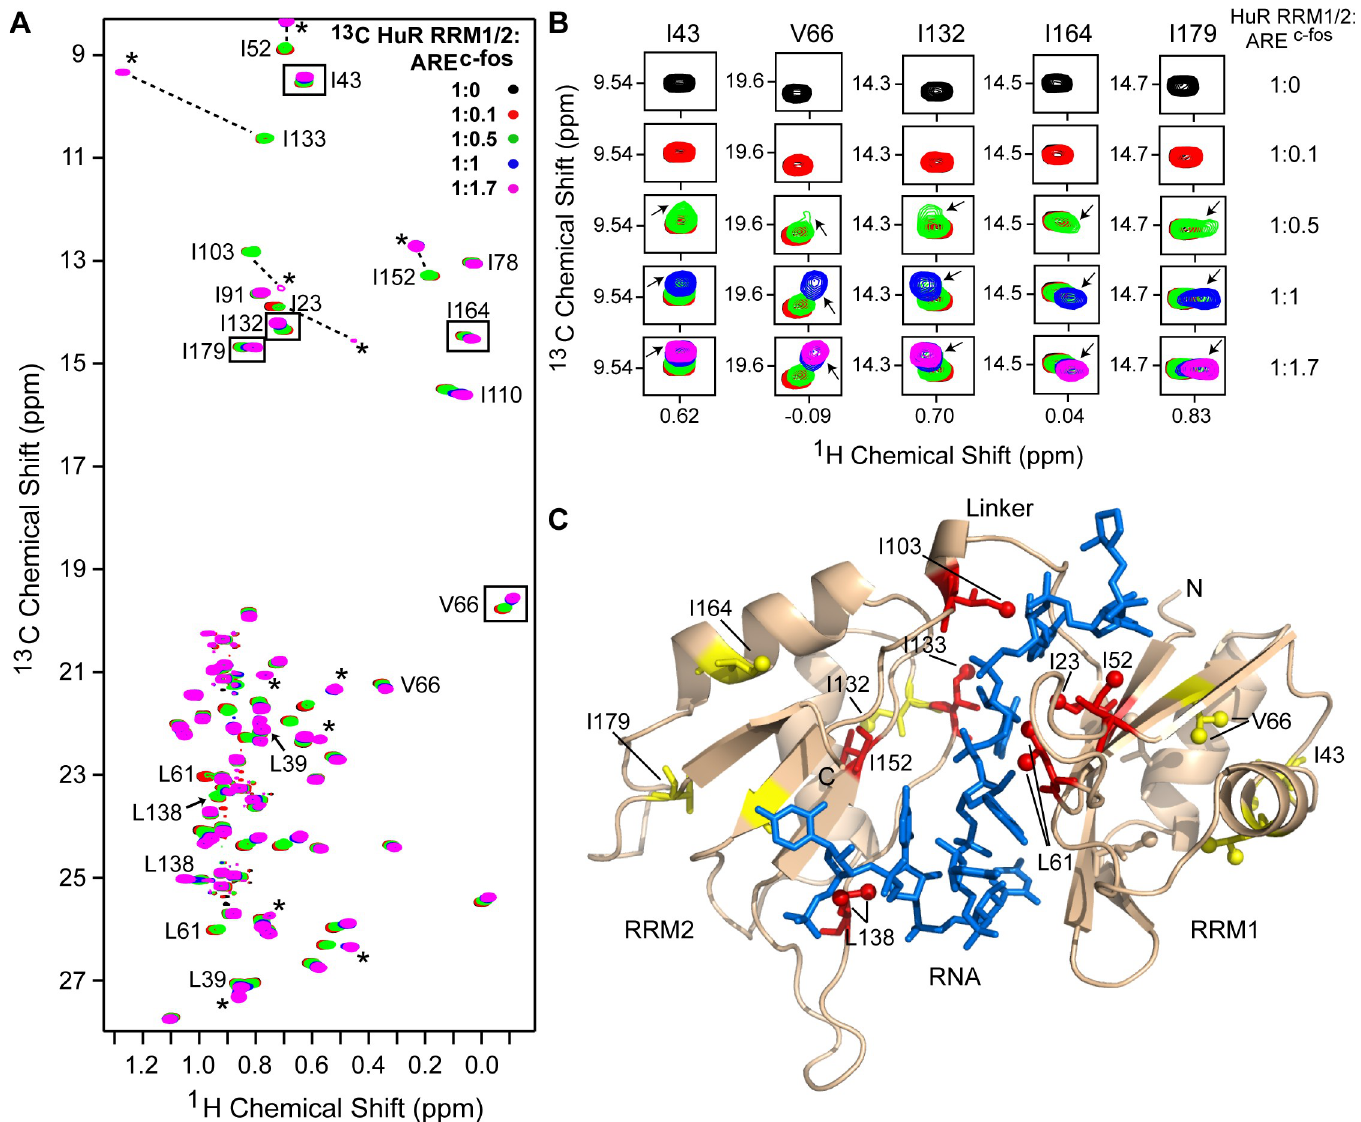
Fig 3. NMR titrations of ILV-labeled HuR RRM1/2 with ARE c-fos . (A) Overlay of five 2D 1 H- 13 C HSQC spectra of ILV-labeled HuR RRM1/2 titrated with increasing concentrations of ARE c-fos . AssignedILV peaks, the new peaks appearingupon complex formation ( * ), and some representative ILV residues away from the RNA-binding site that showedchemicalshift perturbations (boxed) are indicated. (B) The boxedpeaks in A are shown at a similar contour level at individual titration points. The new peak emergingwith increasing concentrations of RNA is shown by an arrow . (C) Results of NMR titration mappedonto the co-crystal structure of HuR-ARE c-fos complex(PDB 4ED5). Protein and RNA are represented as in Fig 2. AssignedILV residuesare shown as sticks and colored as follows: RRM1/2 residues showingnew complex peaks (red) and residues with chemicalshift perturbations as indicatedin B